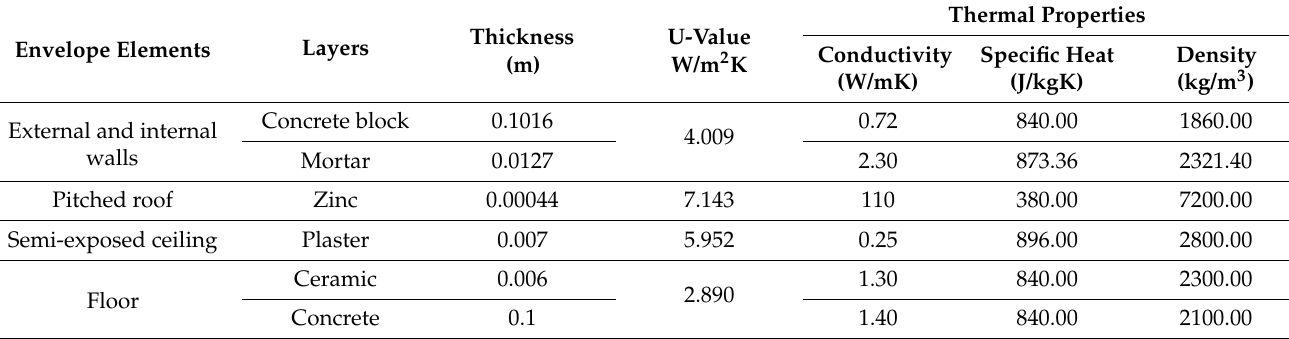
Figure 4. Location of the residential urbanization under study (within the red polygon). Table 2. Thermal properties of the enclosures that make up the